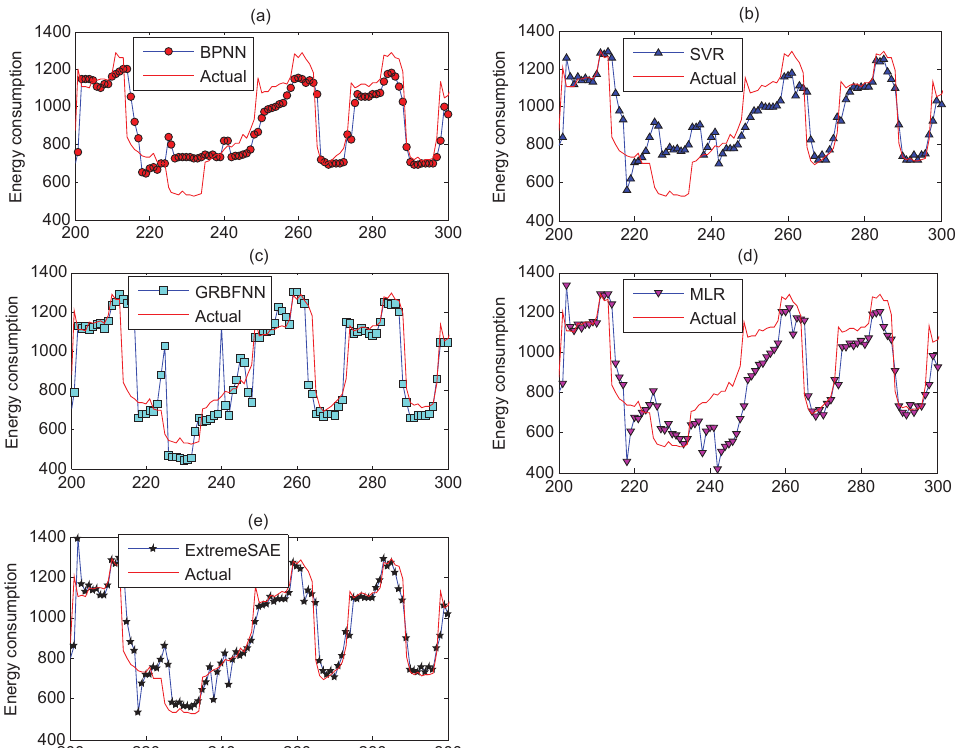
Figure 12. Parts of the zoomed-in prediction results: ( a ) backward propagation neural network (BPNN); ( b ) support vector regression (SVR); ( c ) generalized radial basis function neural network (GRBFNN); ( d ) multiple linear regression (MLR); and ( e ) extreme stacked autoencoder